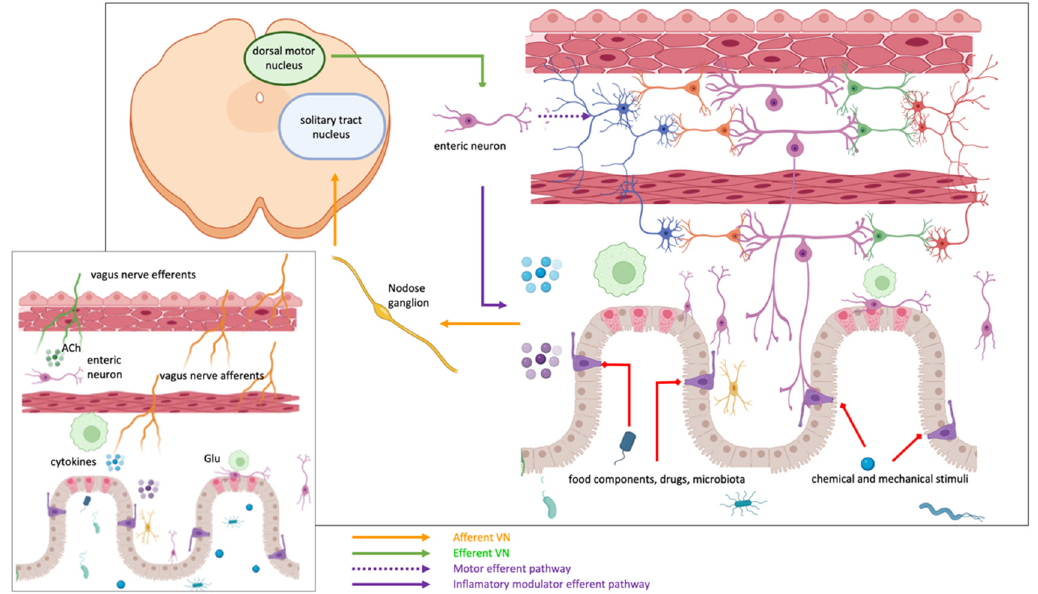
Figure 4. Vagus nerve afferent terminals are mechanoreceptors, chemoreceptors, and thermoreceptors. They are stimulated by muscular tension and stretching, hormones, nutrients, enteroendocrine cells’ neurotransmitters, and inflammatory mediators and are sensitive to osmolarity and pH changes. Their bodies are in the nodose ganglia and transmit information to the nucleus of the solitary tract. The efferent pathways reach the myenteric plexus, where they communicate with (1) enteric neurons that regulate motility and inflammation, (2) with cholinergic neurons that contact macrophages (anti-inflammatory pathway) or (3) with the sympathetic adrenergic system (inflammatory pathway).